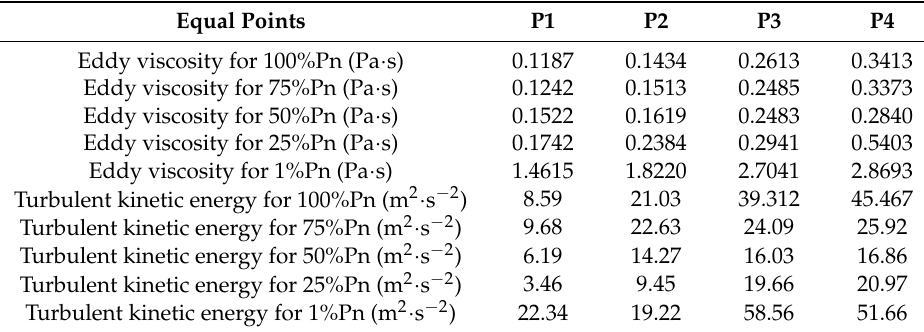
Table 4. Eddy viscosity and turbulent kinetic